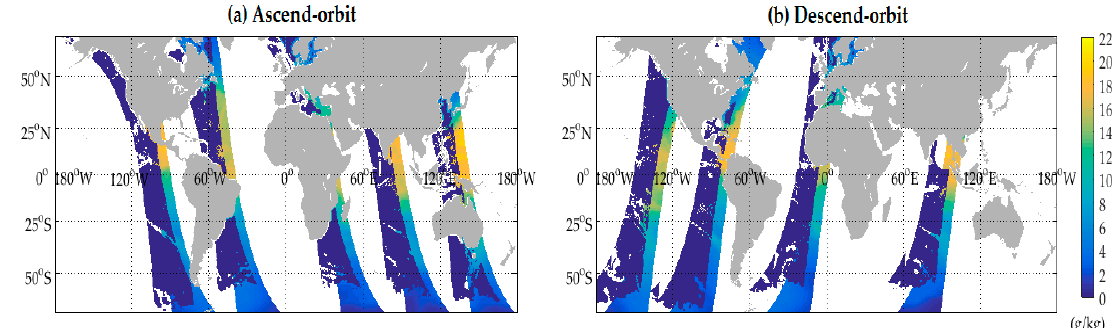
Figure 10. The common coverage area of NOAA CIRES Multi-Satellite Humidity (dark blue strip) and FY-3C humidity (colored strip) on 6 October 2014. Color depth indicates the value of specific air humidity. ( a ) Ascending orbit and ( b ) descending orbit.